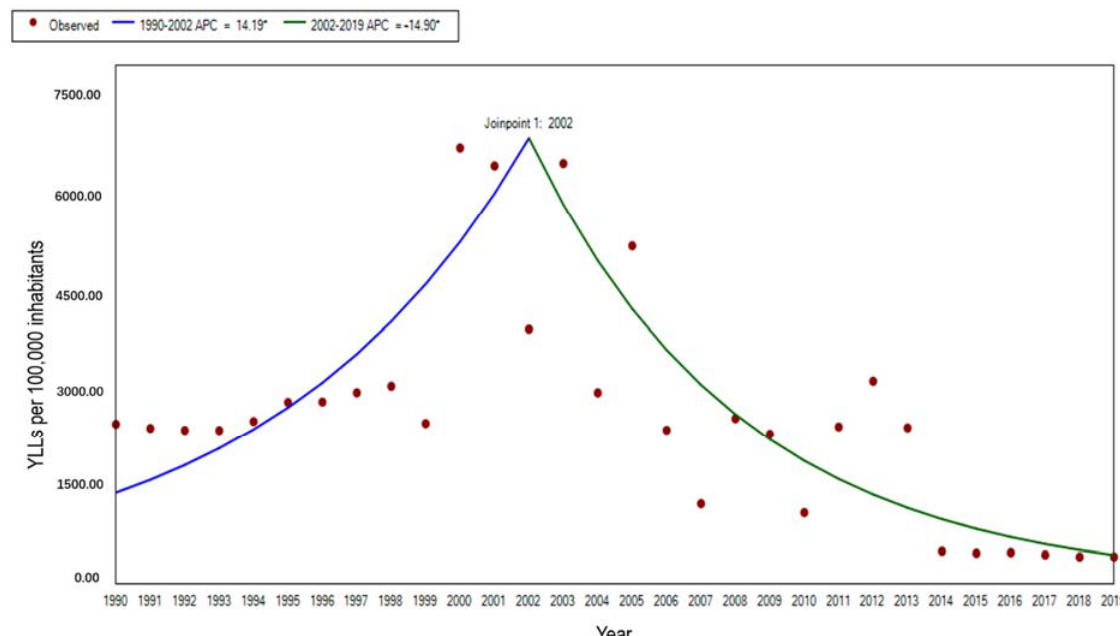
Figure 6. The trend of age ‐ standardized YLL rate for malaria in STP, 1990–2019. Note: * indicates p < 0.05. p <